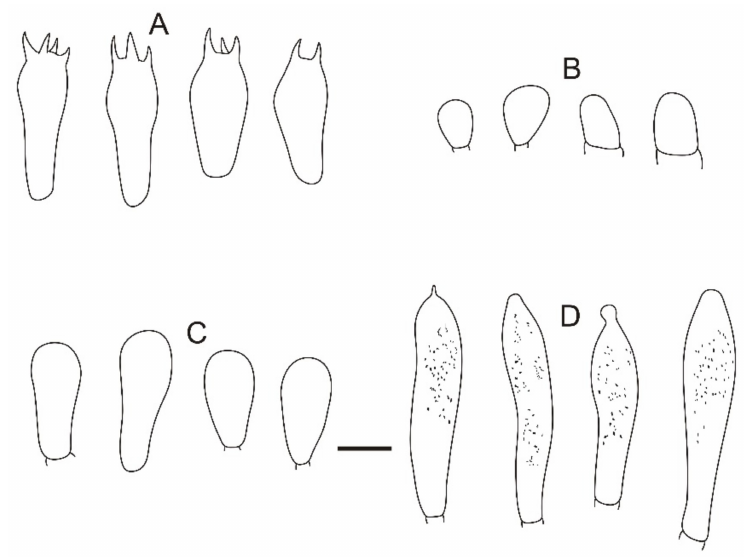
Figure 12. Microscopic features of Russula sinoparva (BJTC ZH441). ( A ) Basidia. ( B ) Basidiola.